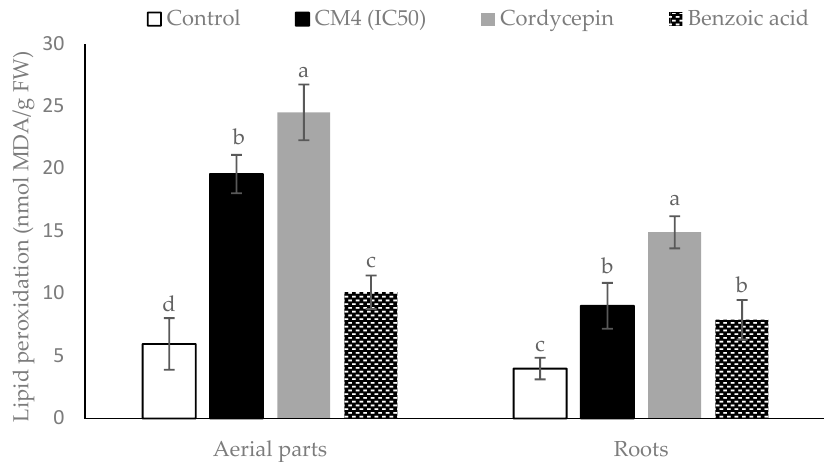
Figure 4. Lipid peroxidation expressed as malondialdehyde ( MDA) accumulation in radish among control and treatments (CM4 fraction, synthetic cordycepin and BA) at 0.04 mg/mL. Columns with different superscript letters ( a,b,c,d ) in bars indicate significant differences at p < 0.05 by Fisher’s test.